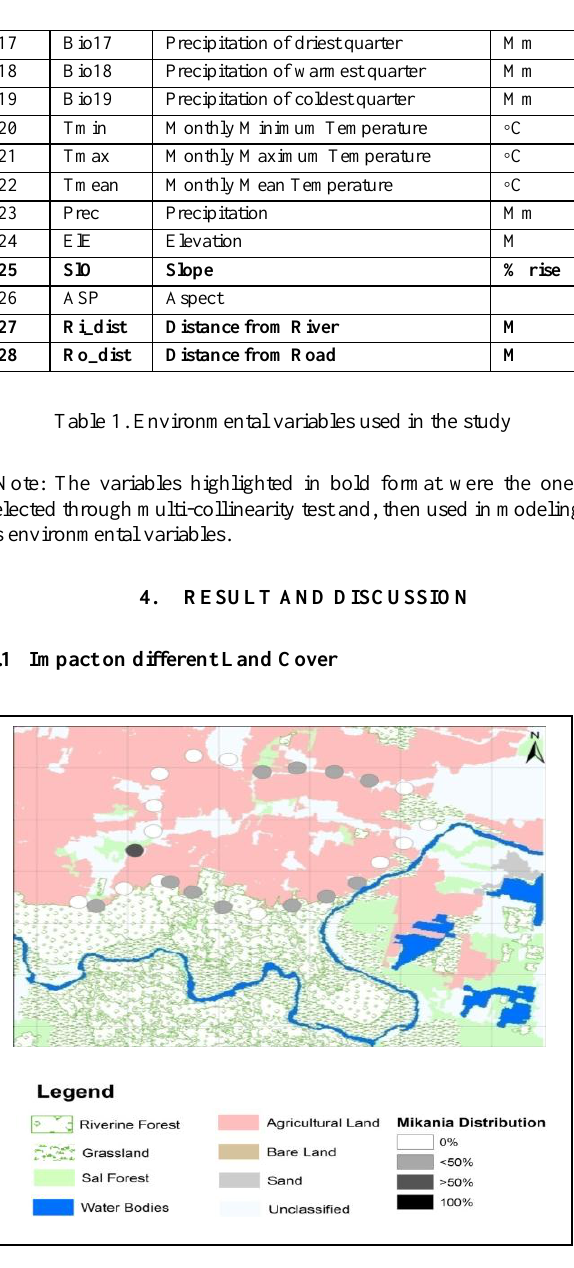
Figure 4. Distribution of Mikania micrantha in Bachhauli VDC The overall accuracy of the classified map was 90% with Kappa coefficient 0.848. From the primary as well as secondary data collected in the field using GPS, the map showing the distribution of Mikania micrantha was prepared. The distribution is shown in graduated colors with 50 m buffer around each sampling